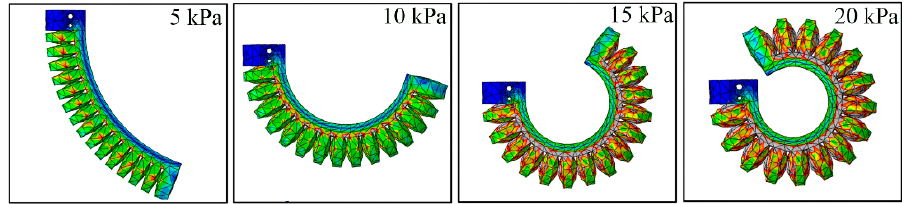
Figure 7. Bending deformation of the traditional soft actuator at the pressure of 5, 10, 15, and 20 kPa.